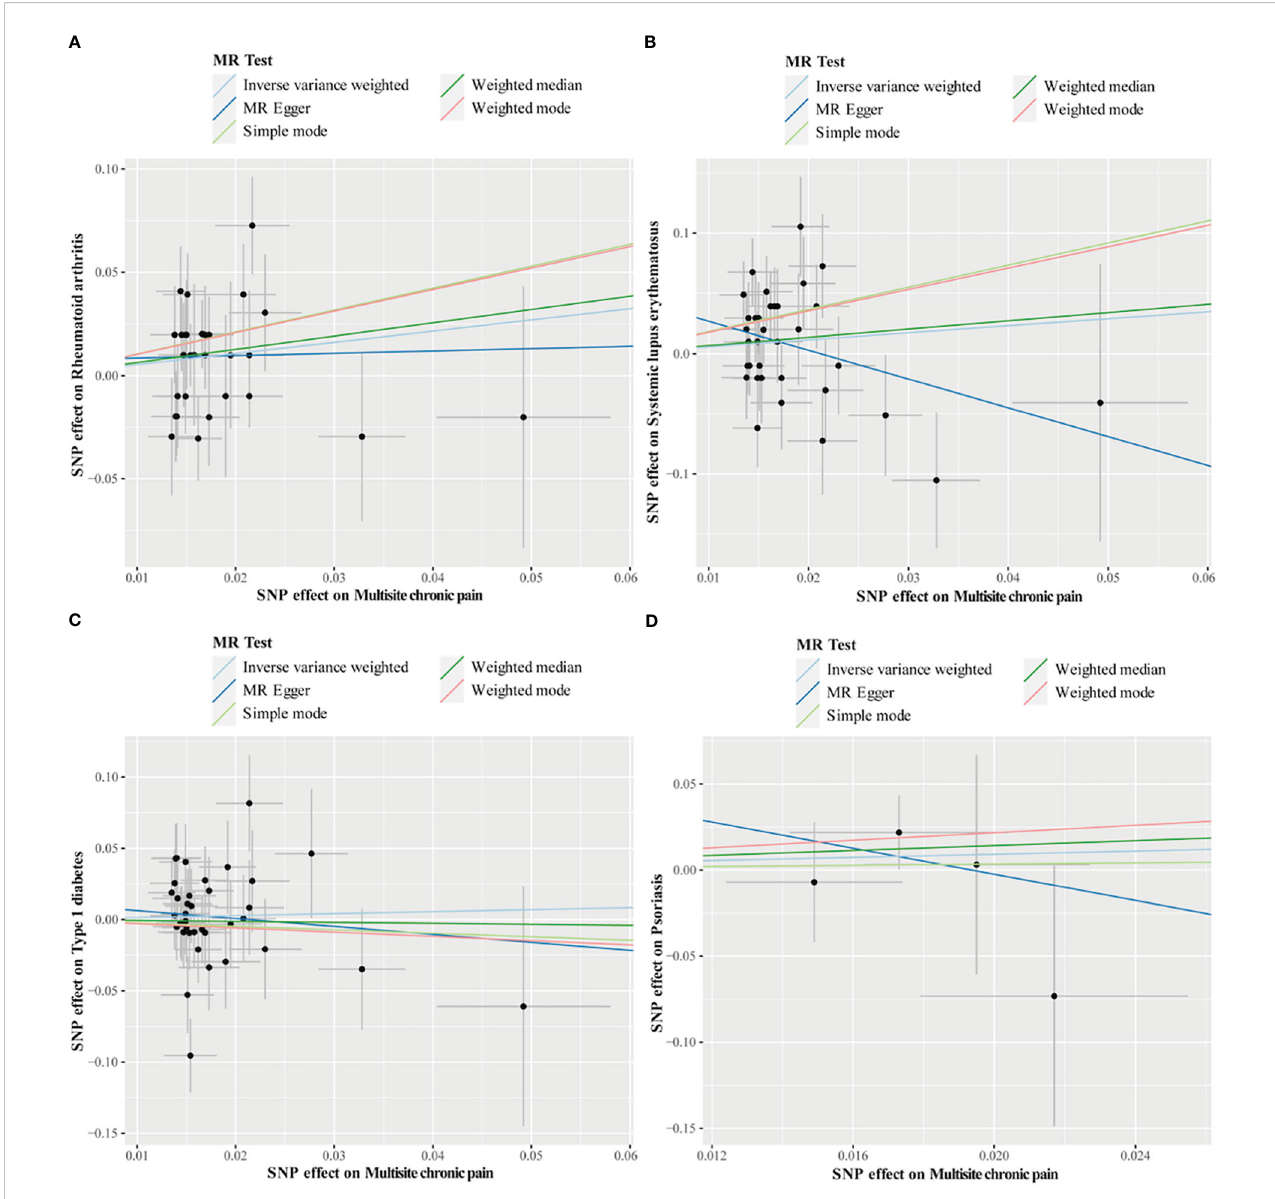
FIGURE 4 Scatter plots of MR analysis. The slope of each line corresponding to the estimated MR effect based on various models. (A) multisite chronic pain on rheumatoid arthritis, (B) multisite chronic pain on systemic lupus erythematosus, (C) multisite chronic pain on type 1 diabetes, (D) multisite chronic pain on